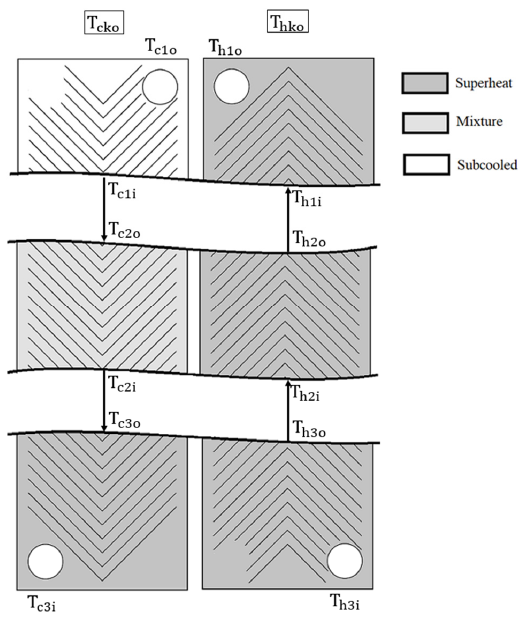
Figure 3. Heat transfer section notation.